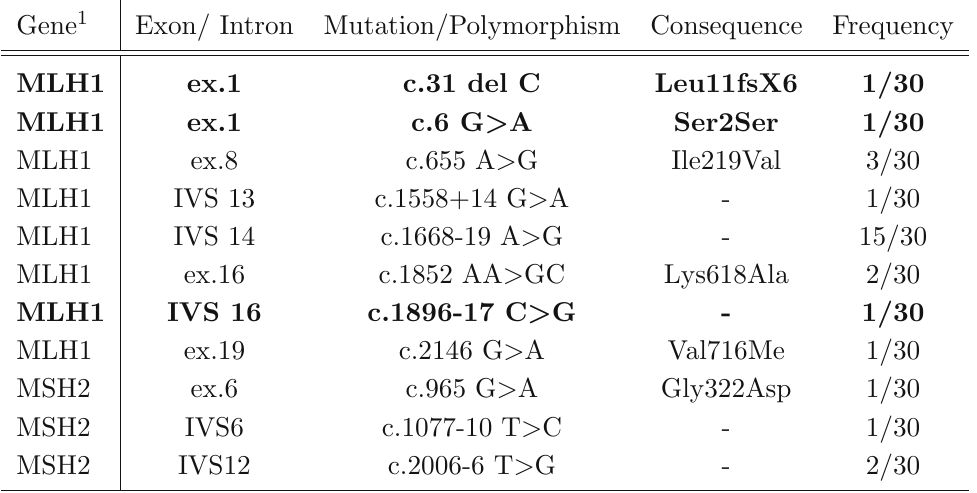
1 GenBank reference sequences: MLH1 - U07343, version U07343.1, CDS 22. 2292 and MSH2 - U03911, version U03911.1, CDS4.2808. Rows in bold – genetic variations not found in other